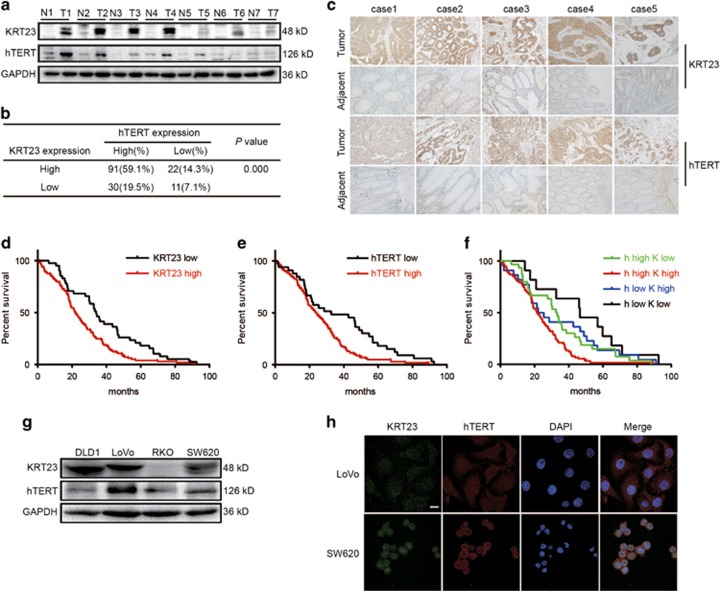
KRT23 and hTERT were highly expressed in CRC tissues and CRC cells. (a) Protein samples extracted from human colorectal tissues and adjacent tissues were used to evaluate the expression of KRT23 and hTERT. (b) The correlation between the KRT23 and hTERT expression in CRC tissues from 154 patients. (c) The expression and distribution of KRT23 and hTERT in CRC tissues and their adjacent non-cancer tissues through immunofluorescence analysis (× 200). (d) Kaplan–Meier analysis of the overall survival of CRC patients with different KRT23 expression levels (P<0.05, log-rank test). (e) Kaplan–Meier analysis of the overall survival of CRC patients with different hTERT expression levels (P<0.05, log-rank test). (f) Kaplan–Meier analysis of the overall survival of CRC patients with different KRT23 and hTERT expression levels (P<0.05, log-rank test). (g) KRT23 and hTERT expression levels in CRC cells were measured by western blot using anti-KRT23 and hTERT antibodies. (h) The expression levels of KRT23 and hTERT in CRC cells (LoVo and SW620) were detected by immunofluorescence assay. The localization of KRT23 and hTERT is shown. Green, KRT23; red, hTERT; blue, nuclei (× 1200)